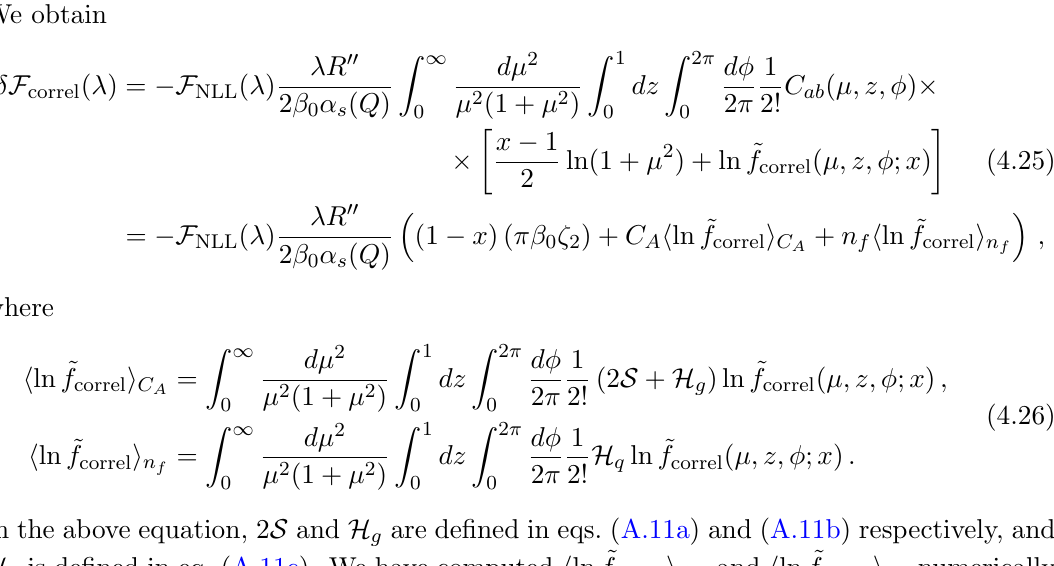
and h ln ~ f correl i n A